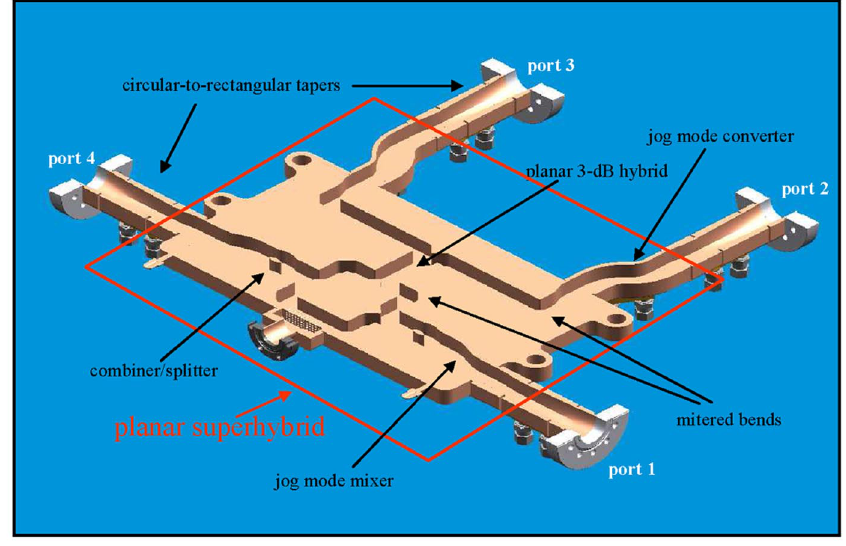
FIG. 9. (Color) The design of the dual-moded superhybrid (a split view).